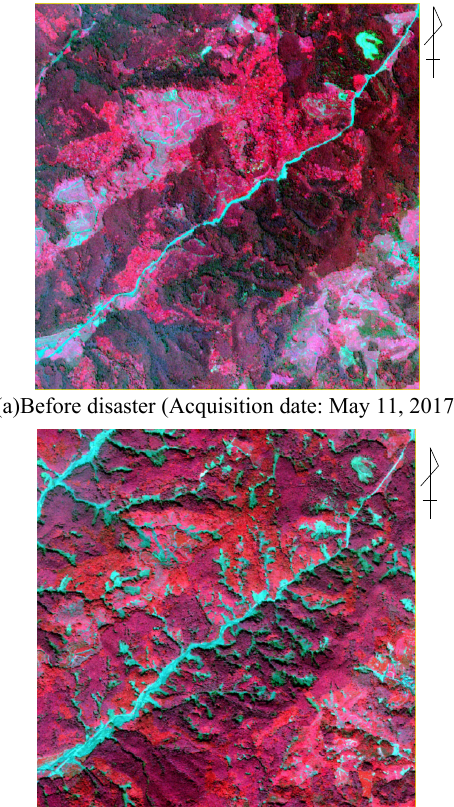
(b)After disaster (Acquisition date: September 13, 2017) Figure 2. The false color image in test area(2km × 2km)